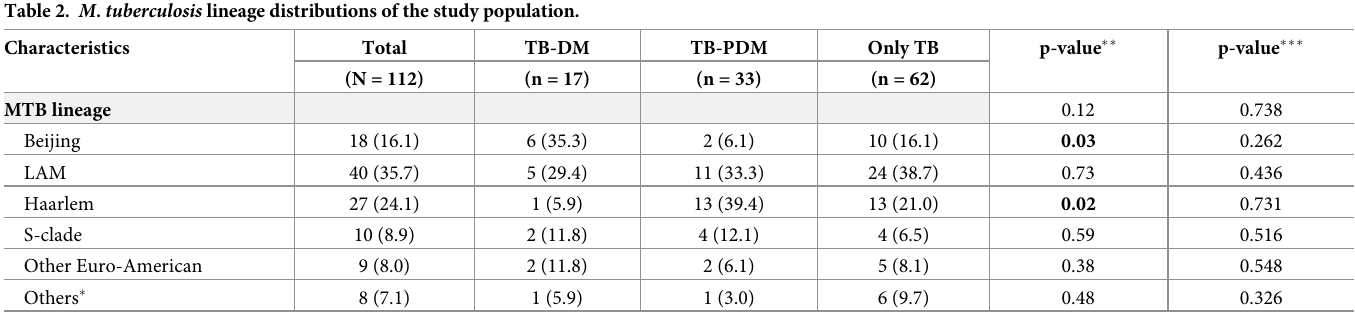
Table 2. M . tuberculosis lineage distributions of the study population.